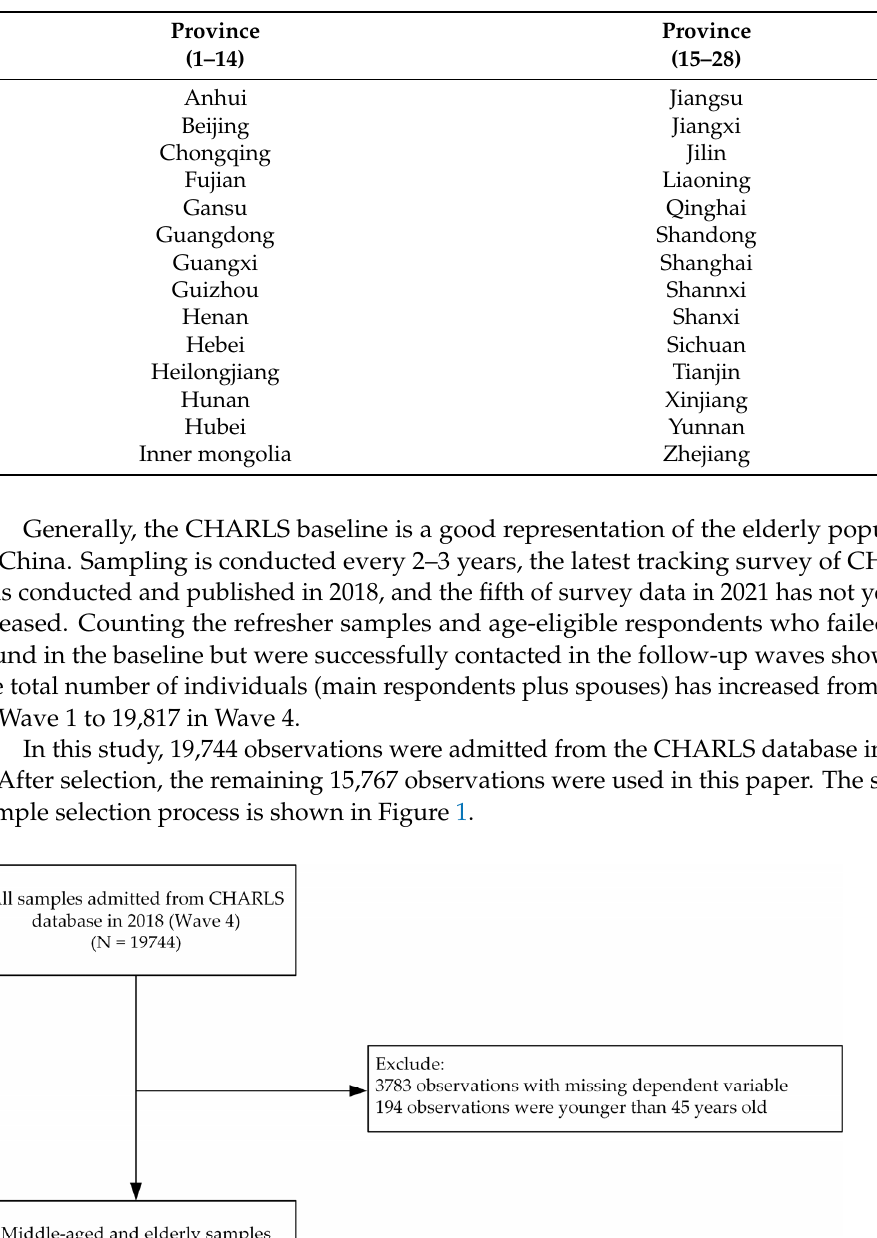
Table 1. The 28 provinces from which the CHARLS baseline survey samples came from.